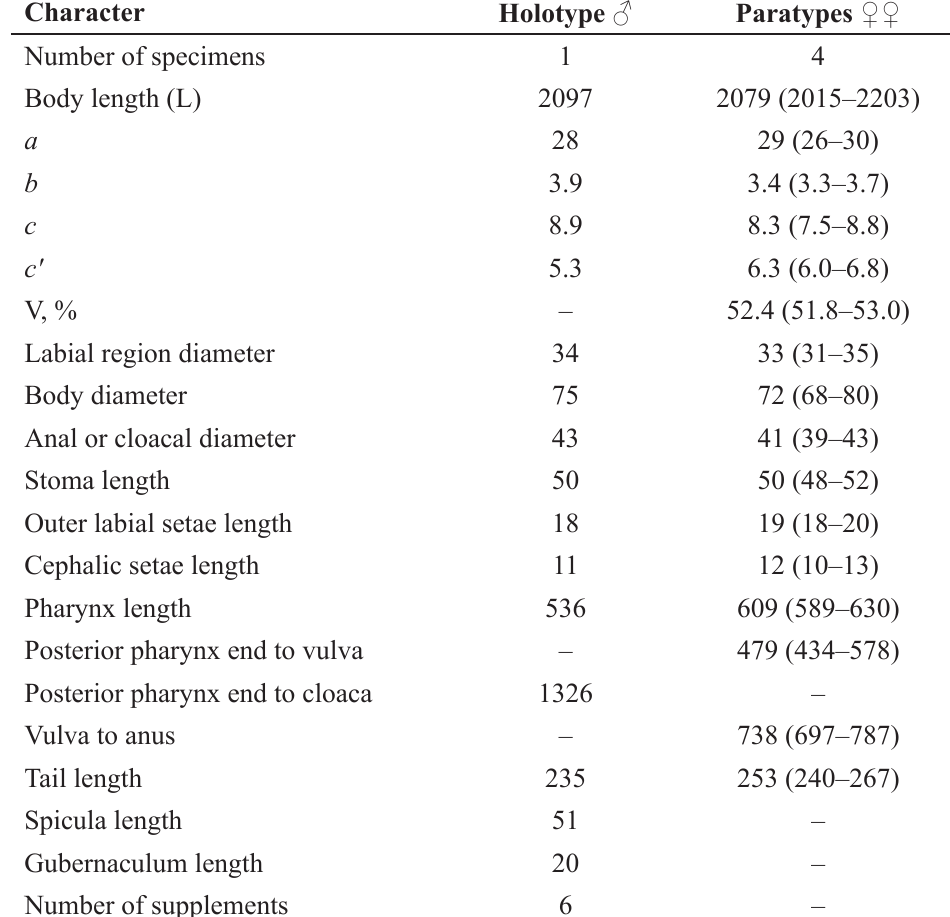
Table 2. Measurements (in µm) of Paratrilobus aquaticus sp. nov., presented as mean and